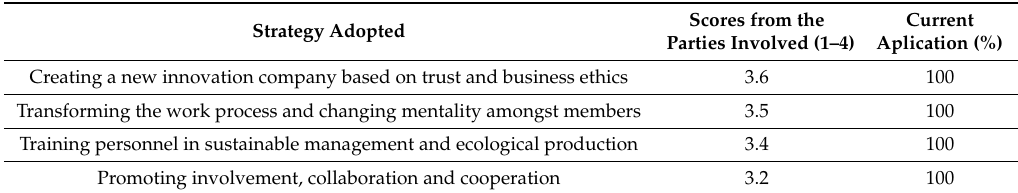
Table 1. Ethical-social dimension strategies